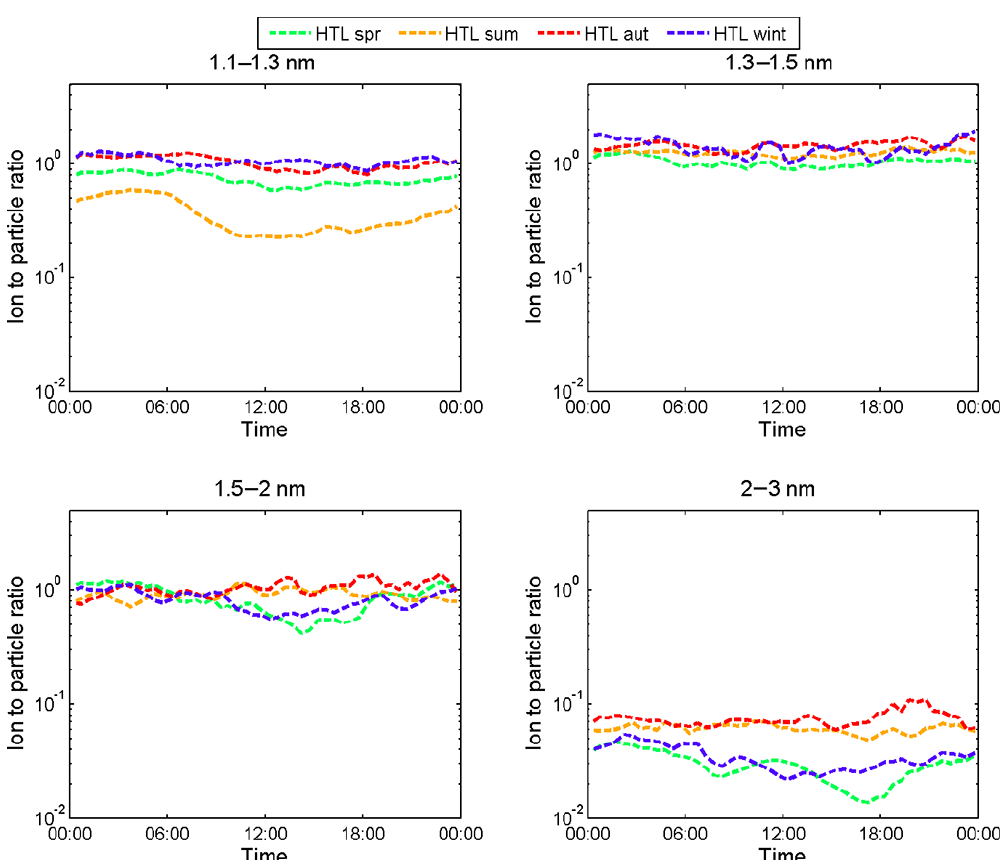
Figure 9. The median diurnal variation in the ratio of ion concentration to the total particle concentration in four size bins (1.1–1.3, 1.3–1.5, 1.5–2, and 2–3nm) in Hyytiälä in 2011 and 2015–2016. The data are divided into different seasons: spring (spr), summer (sum), autumn (aut), and winter